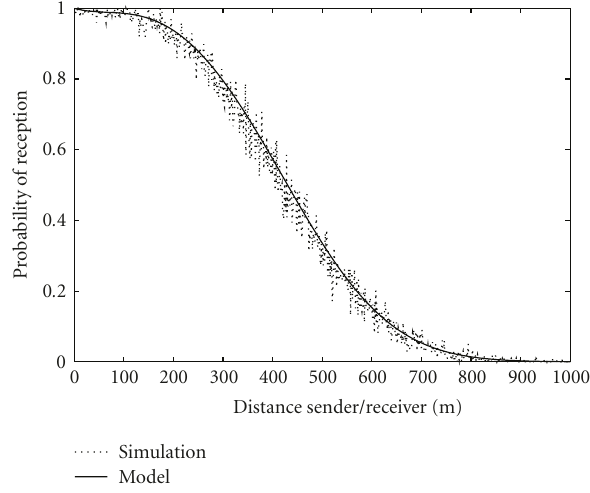
Figure 6: Comparison between model and simulation results: the figure illustrates the scenario ( δ = 25veh/km, f = 10Hz, ψ = 500m) for which the maximum sum of squared error has been determined.